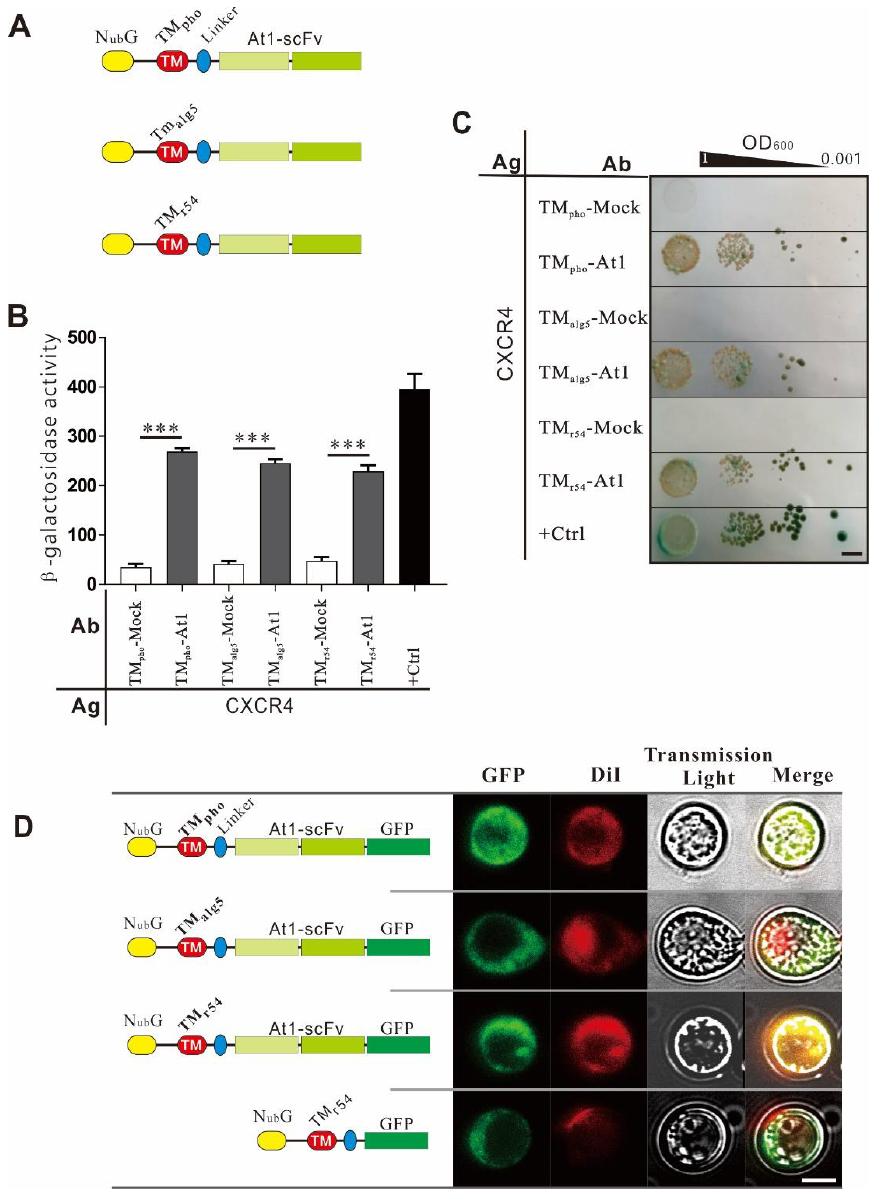
Figure 3. Optimization of transmembrane (TM) peptides. ( A ) Diagram of scFv modules with different TM peptides. Three transmembrane peptides (TM Pho , TM alg5 , and TM r54 ) were fused between the N ub G domain and flexible linker (3×GGGGS), followed by At1-scFv in tandem. ( B ) β -Gal assay. The interaction strength between the antigen (CXCR4) module and the antibody (At1-scFv) module containing different TM peptides was measured using the β -galactosidase assay. The positive control was the same as in Figure 2E, the bar indicate 5 mm. ( C ) Cell growth assay. The growth of hybrid cells harboring antigen and antibody modules (same as B) were evaluated on the selection medium. ( D ) Subcellular localization of anti- body modules with different TM peptides. pGBK-T7-At1-scFv-TM-N ub G was used as the backbone of antibody plasmids. TM Pho , TM r54 , and TM alg5 were fused between the N ub G domain and linker (3×GGGGS), followed by At1-scFv and EGFP in tandem. pGBK-T7-EGFP-TM Pho -N ub G was used as a positive control. The antibody modules were expressed by Y187 and observed using laser scanning confocal microscopy. Images of EGFP, membrane-specific fluorescent dye DiI, and trans- mission light were captured and merged, the bar indicates 5 μ m.